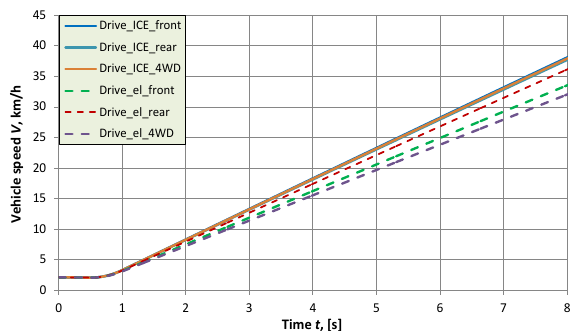
Fig. 4. Forces and moments acting on the vehicle [14]